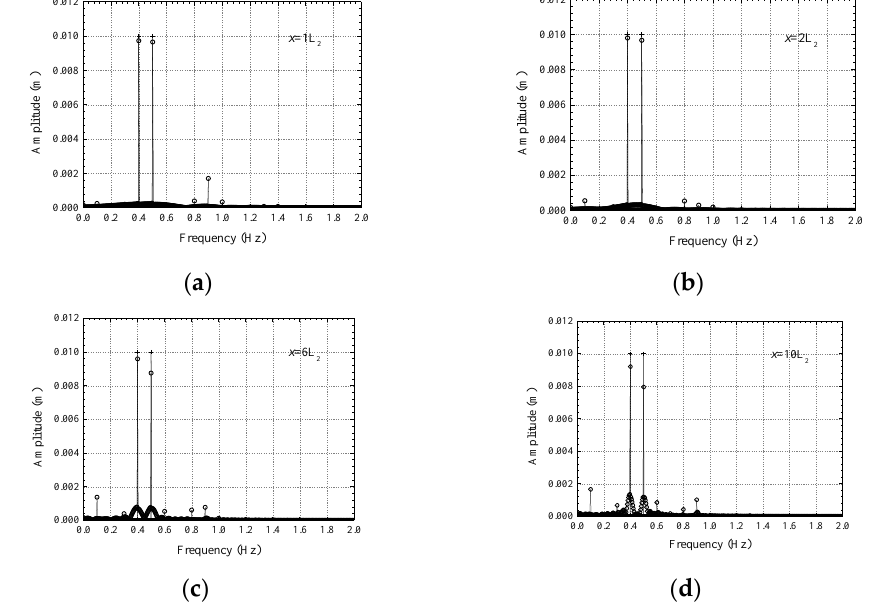
Figure 4. Frequency domain plots of wave simulation results at X = 1L 2 ( a ), X = 2L 2 ( b ), X = 6L 2 ( c ), X = 10L 2 ( d ) of the MIKE 21 BW model ( ○ ) and the theoretical solution ( ┼ ) (operating condition C1).